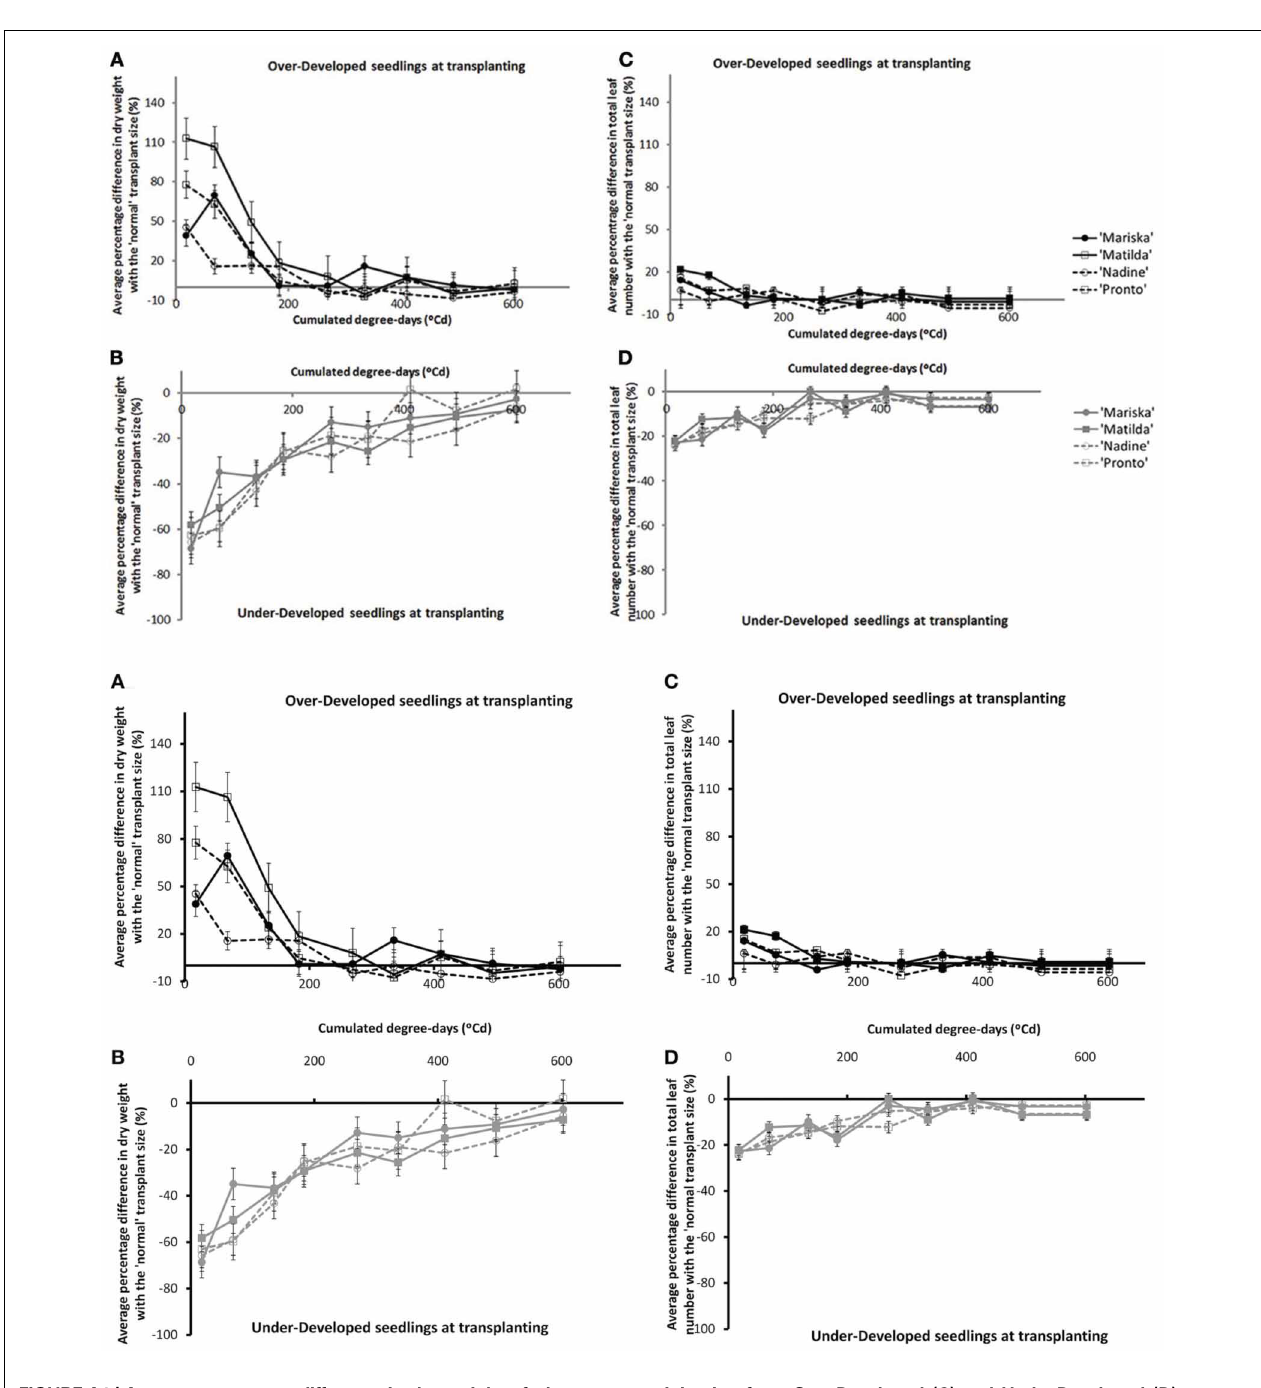
originating from Over-Developed (C) and Under-Developed (D) seedlings in comparison with the number of leaves counted on plants originating from Normally Developed seedlings for the four cultivars (trial Wageningen 2009). Error bars indicate ± one standard